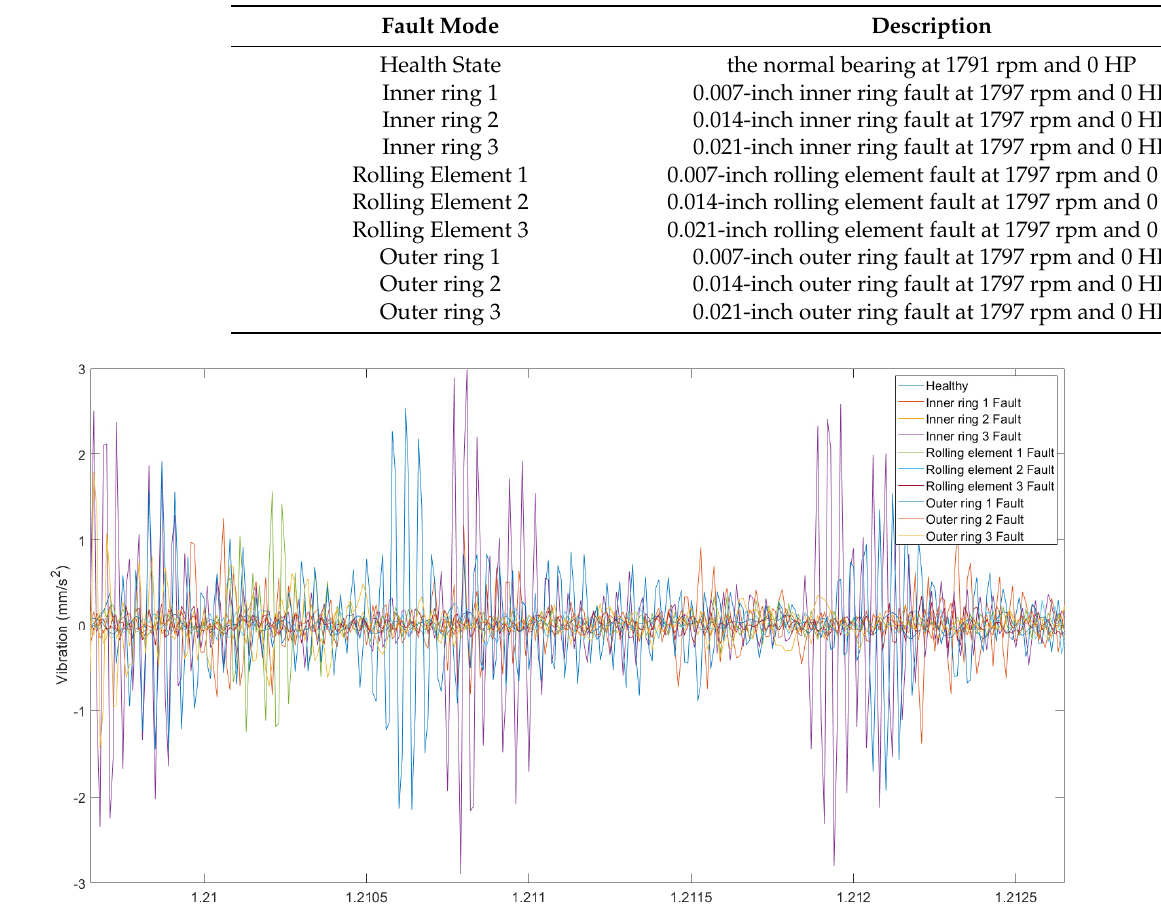
Table 7. CWRU faults.